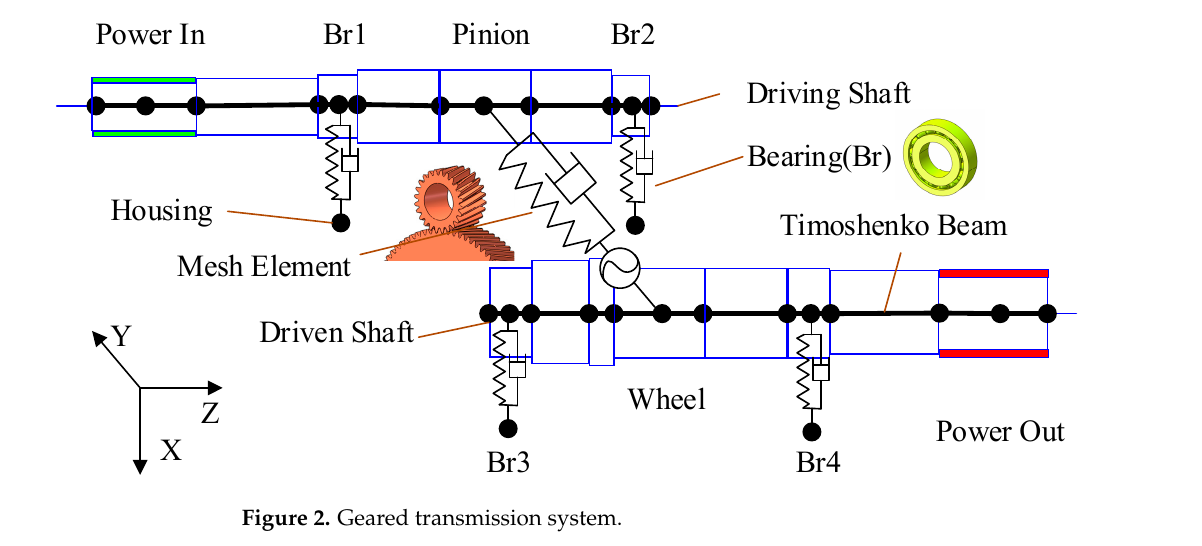
Figure 2. Geared transmission system. For linear gear systems, the time-varying parameters in Equation (2) are periodic. So after removing the mean term and performing Fourier transform, the frequency form of Equation (2) yields.